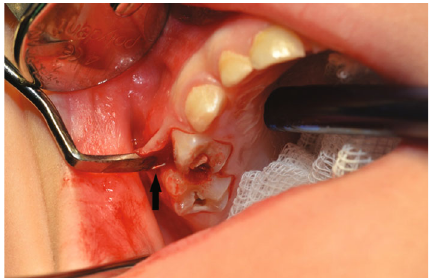
Figure 4: Surgical retrieval of a broken needle (black arrow).